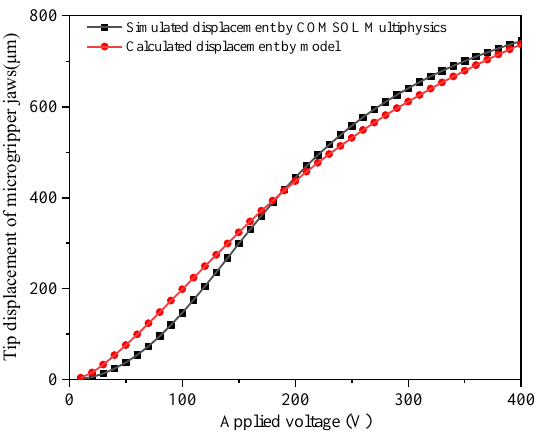
Figure 14. Static performance of the electrostatic repulsive unit in the opto-electrostatic actuator.